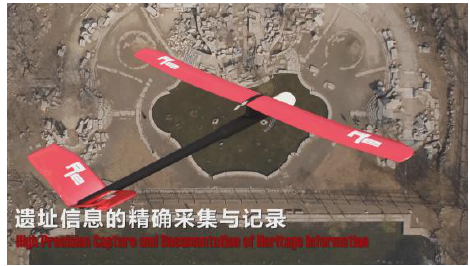
Figure 5:UVAs collect site information with high accurately